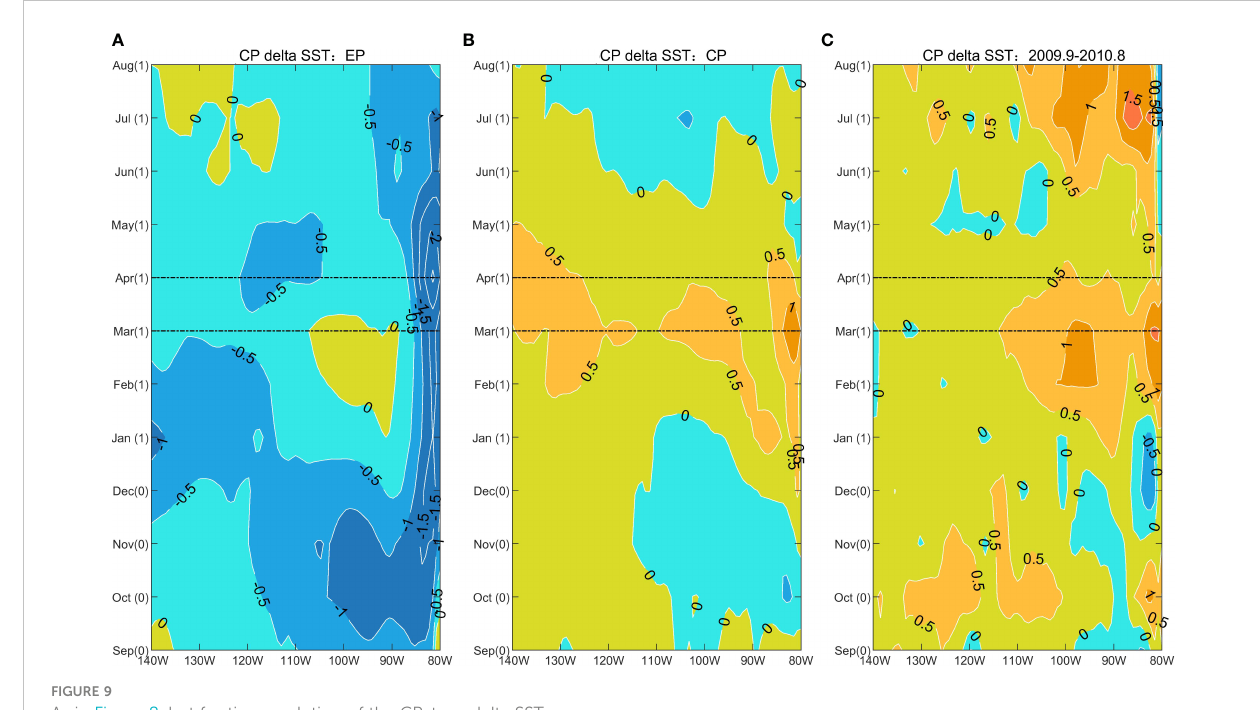
FIGURE 9 As in Figure 8, but for time evolution of the CP-type delta